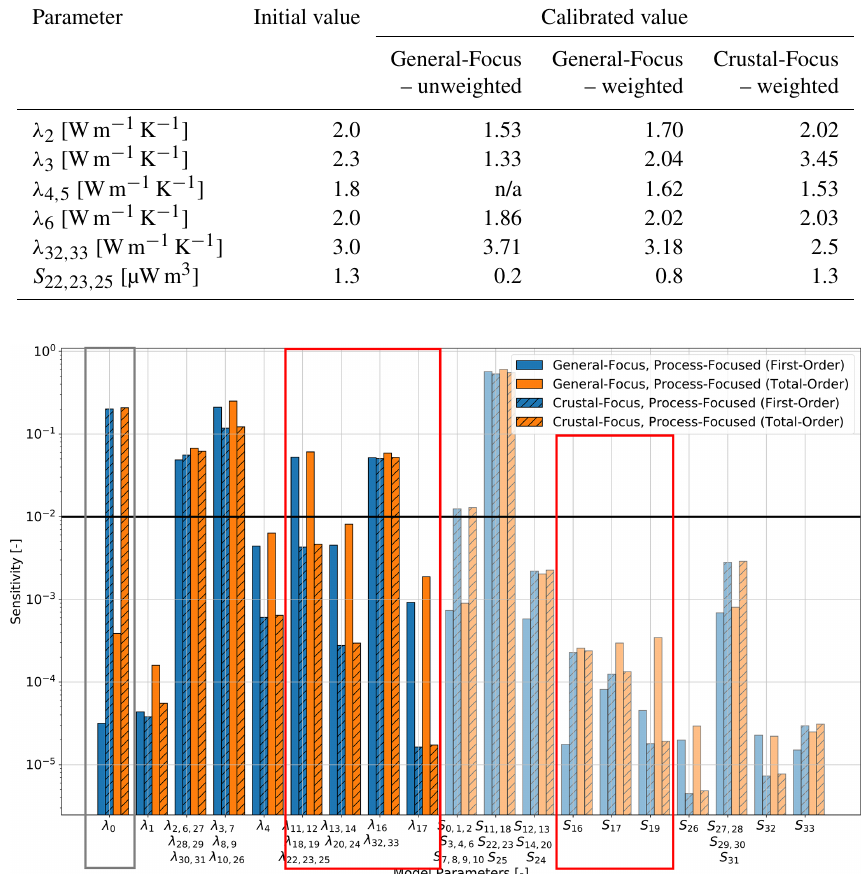
Figure 15. Comparison of the sensitivities of the process-focused study for both the General-Focus and Crustal-Focus Alps model. The solid black line denotes the threshold value for determining if the parameters are influencing the model